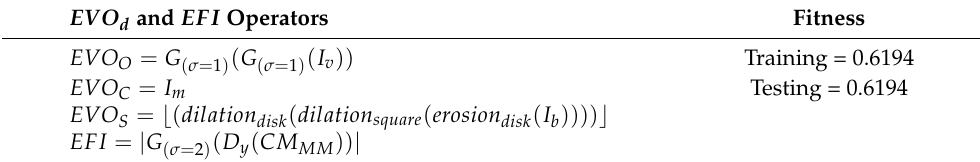
Table 16. Program structure of the operators corresponding to the best solution for the PASCAL-S database. We select this solution from the 30 executions of Table 15. The final solution is similar to all others discovered by the system. This shows that the proposed programs are independent of the selected dataset.